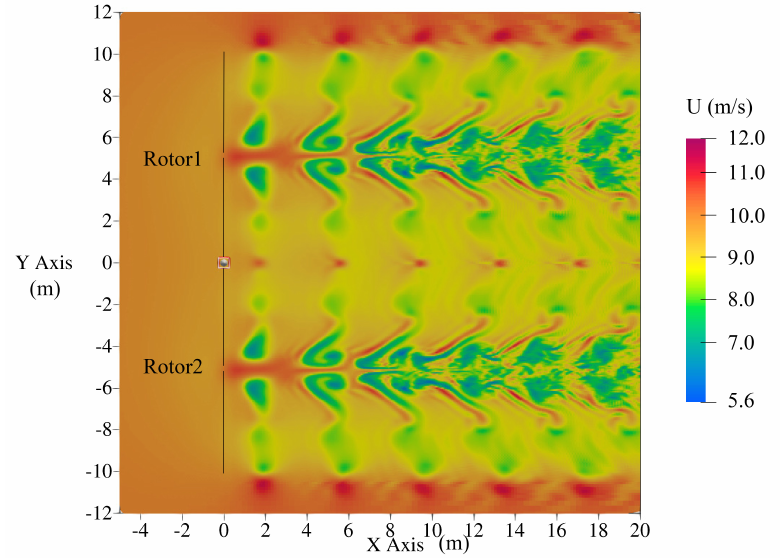
Figure 4. Velocity contour in the x - y plane of the twin-rotor turbine near the wake at z = 12.2